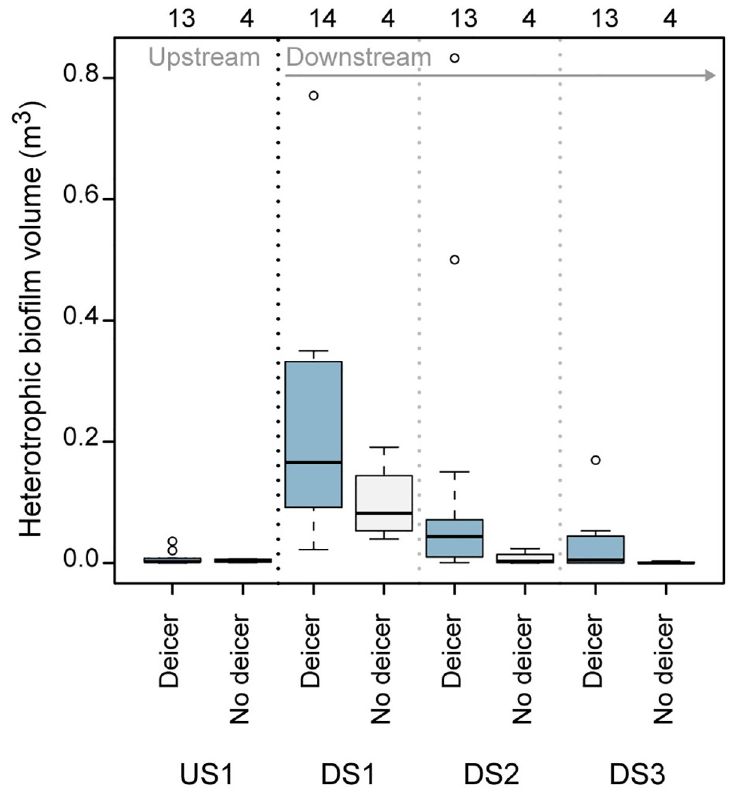
Fig 2. Volume of biofilms dominated by heterotrophic bacteria during months with deicer influence (December- May) and those without deicer influence (June-November). Volumes have been normalized to a standard reach size of 50 square meters; number of samples included in each box are given above the graph. Boxplot components represent the following statistics: the midline is the median, the box extends from the 25 th to 75 th percentiles (i.e., the interquartile range), the whiskers extend to the farthest data point within 1.5 times the interquartile range from the edge of the box in either direction, and circles are individual data points falling beyond that